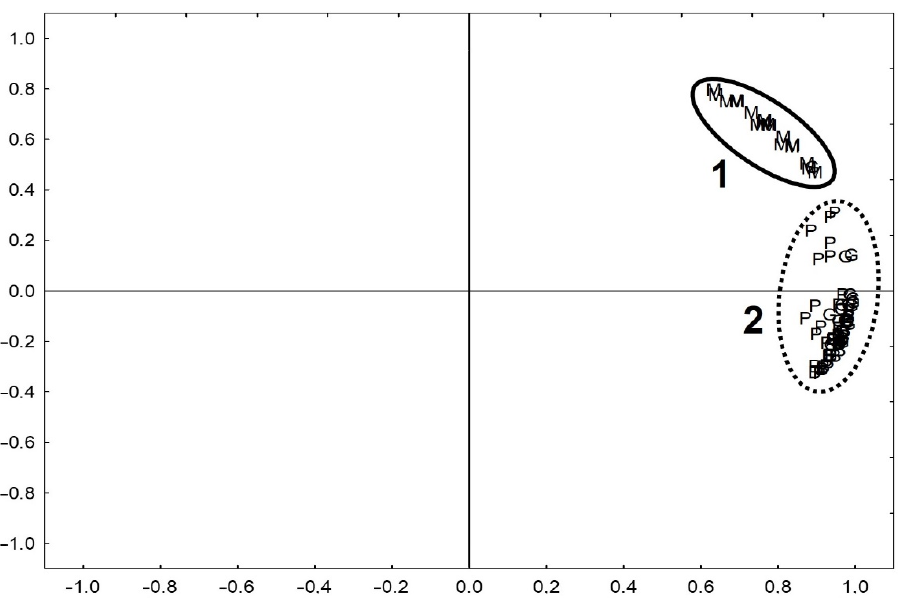
Figure 1. Results of Principal Components Analysis for elements concentration in pottery samples from four archaeological sites (Borzejewo (B), Pozna ń -Nowe Miasto (P), Grabkowo (G), Moldova(M)); 1—the group of samples from site M (Moldova), 2—the group of samples from the other